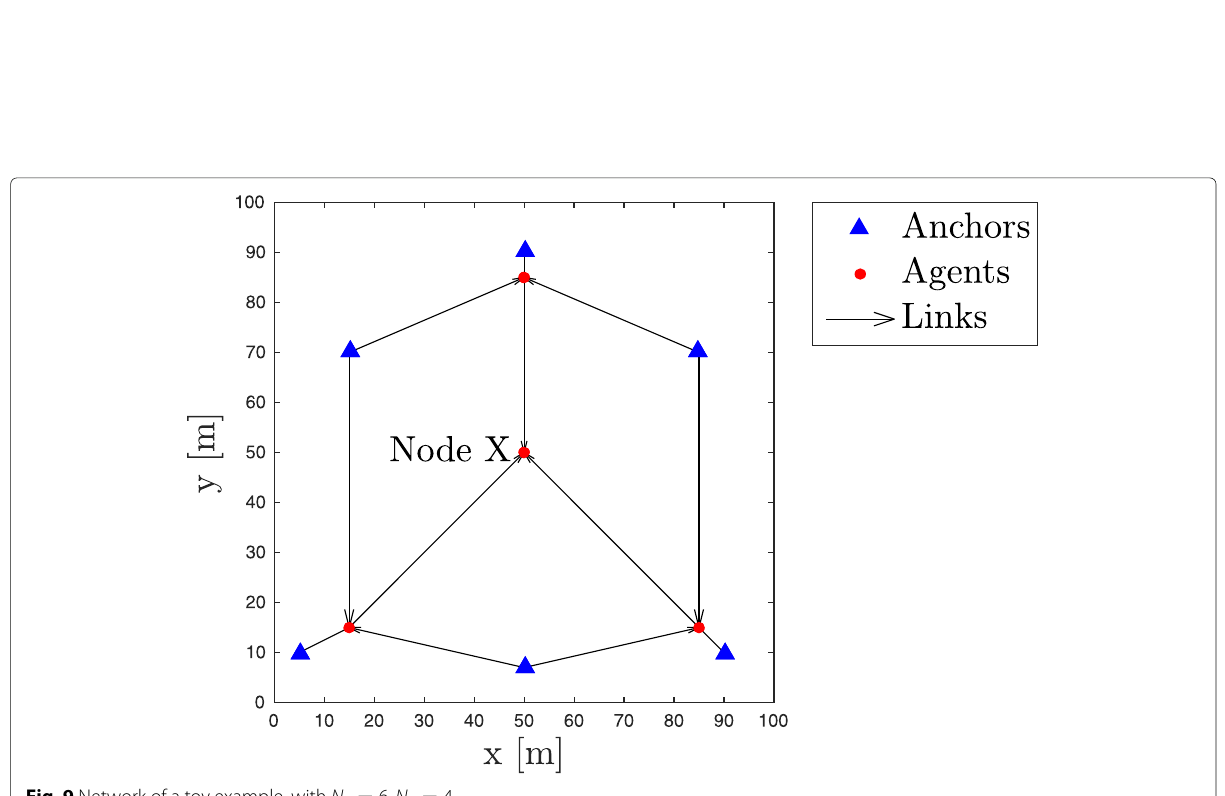
Fig. 9 Network of a toy example, with N a = 6, N u =